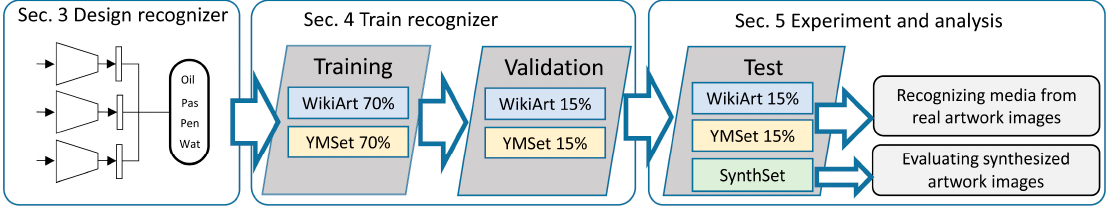
Figure 3. Three datasets for our approach.